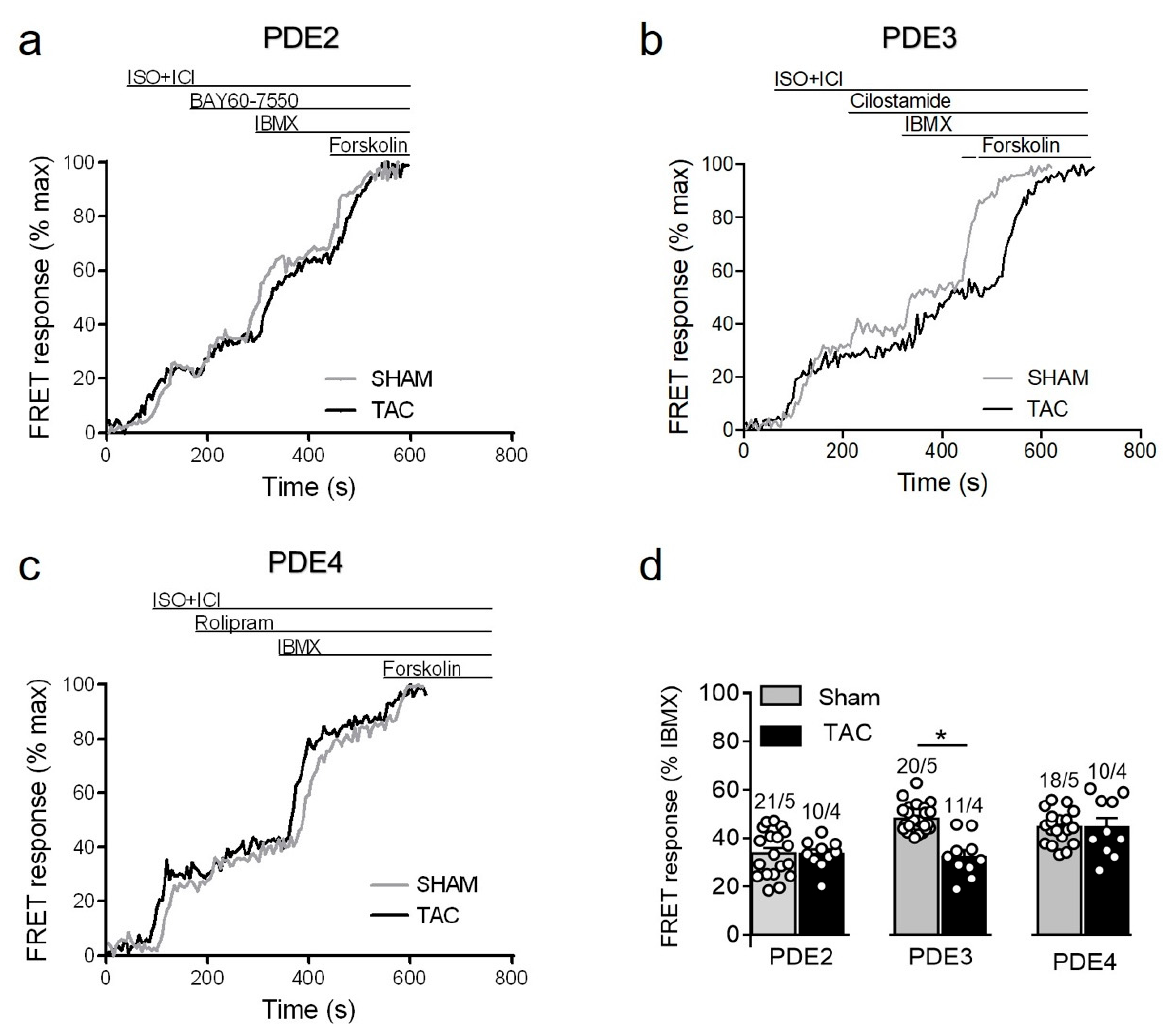
Figure 5. cAMP responses measured upon selective PDE2, PDE3, and PDE4 inhibition after submaximal β 1 -AR stimulation in sham and TAC myocytes. Representative FRET ratio traces recorded from cells in response to β 1 -AR stimulation with 3 nmol/L ISO in the presence 50 nmol/L ICI118551 (ISO+ICI), followed by ( a ) 100 nmol/L of the PDE2 inhibitor BAY60-7550, ( b ) 10 µmol/L of the PDE3 inhibitor cilostamide, and ( c ) 10 µmol/L of the PDE4 inhibitor rolipram. PDE inhibitor responses were calculated as a% maximal PDE inhibition by IBMX (100 µmol/L). Forskolin (10 µmol/L) was applied at the end of each experiments to obtain the maximal FRET response. ( d ) Quantification of PDE inhibitor responses in sham and TAC myocytes. Means ± SE. Number of cells/mice are stated above the bars. * p < 0.05 by mixed ANOVA followed by Wald’s chi-squared test.